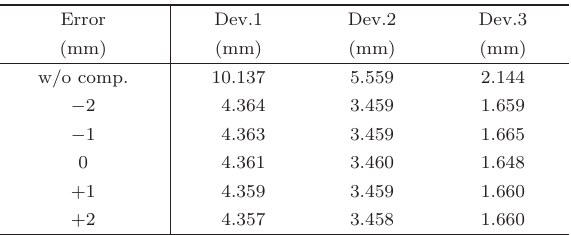
Table 5 Residual errors with varying baseline length errors Error